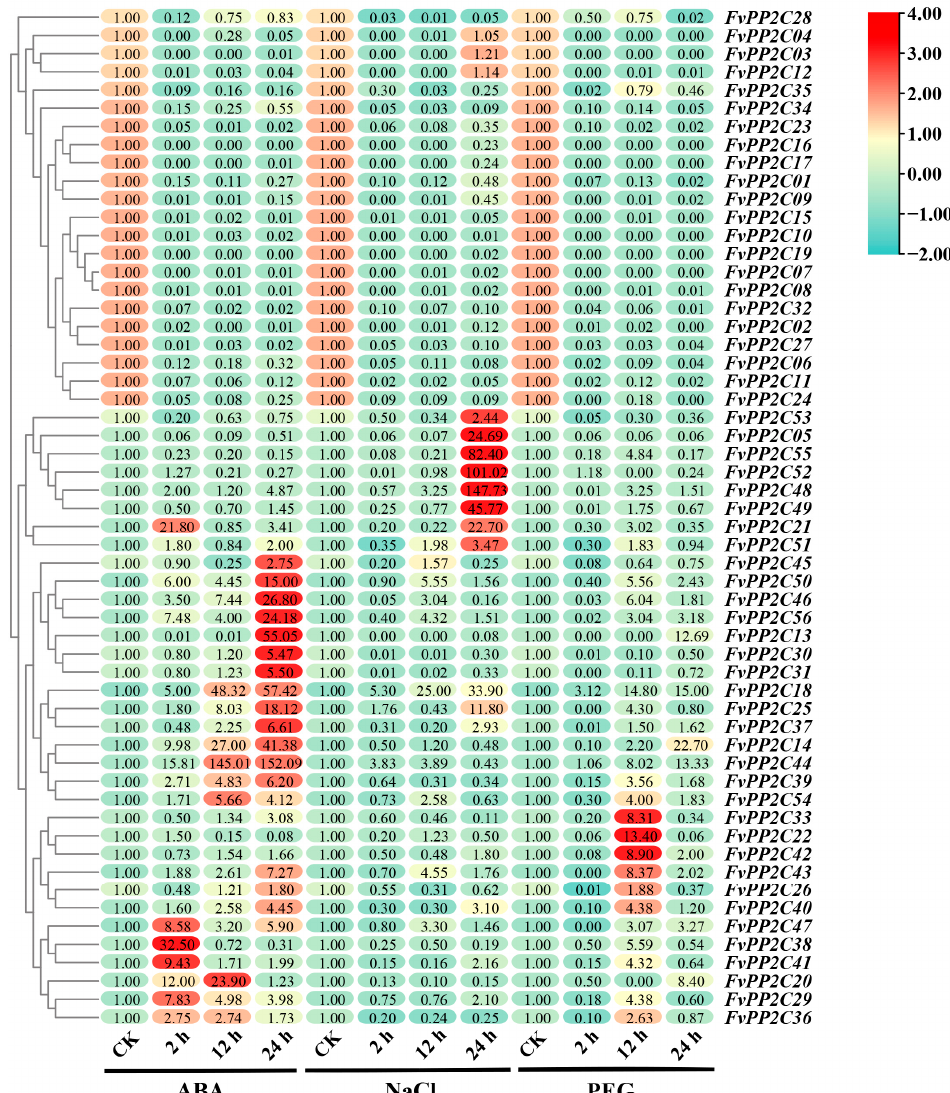
Figure 9. Quantitative real-time PCR analysis of the FvPP2C genes in response to the ABA, NaCl, and PEG treatments. Note: The tissue culture seedlings of F. vesca were sampled after 2 h, 12 h, and 24 h under 10% PEG, 100 µ M ABA, 200 mM NaCl, and equal volume water treated using FvGAPDH as the endogenous control. The 2 − ∆∆ Ct method was used to calculate the relative expression. Green represents low expression, yellow represents medium expression, and red represents high